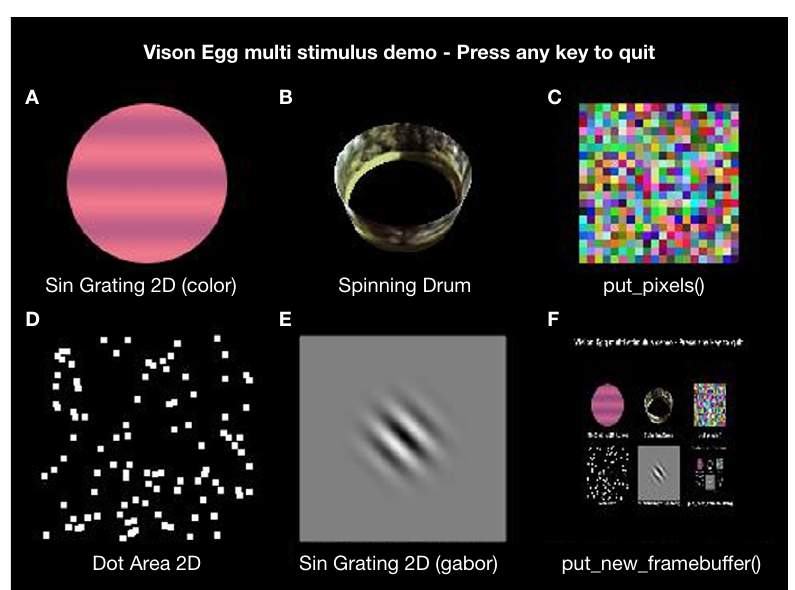
Figure 1 | Screenshot of Vision Egg multi_stim.py demonstration script showing several included visual stimulus types. The dynamic stimuli are updated in realtime without skipping frames at rates up to the fastest vertical refresh rate of the display tested (200 Hz). Stimuli, are: (A) A circularly windowed color grating changing in space and color over time. (B) A rotating, perspective distorted drum with a natural panorama used as a texture image. (C) Arbitrary arrays of RGB data updated on each frame generated from a uniform random distribution. (D) Random dot stimuli with 100 independently moving dots. (E) A drifting Gaussian windowed sinusoidal grating. (F) A copy of the framebuffer recursively redrawn at smaller